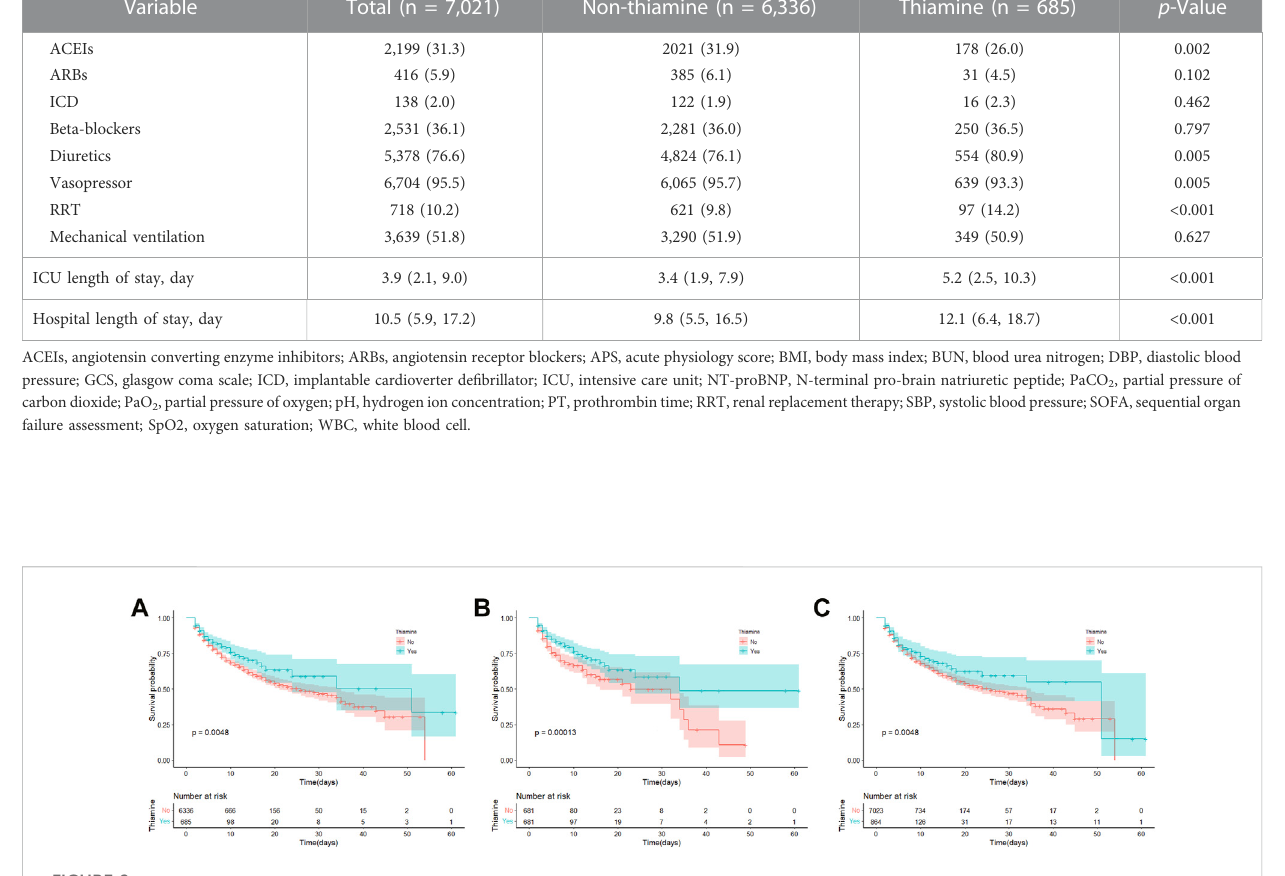
FIGURE 2 Kaplan-Meier survival curves between the thiamine and none-thiamine groups. (A) The original population; (B) After propensity score matching adjustment; and (C) After propensity score-based inverse probability of treatment weighting adjustment.